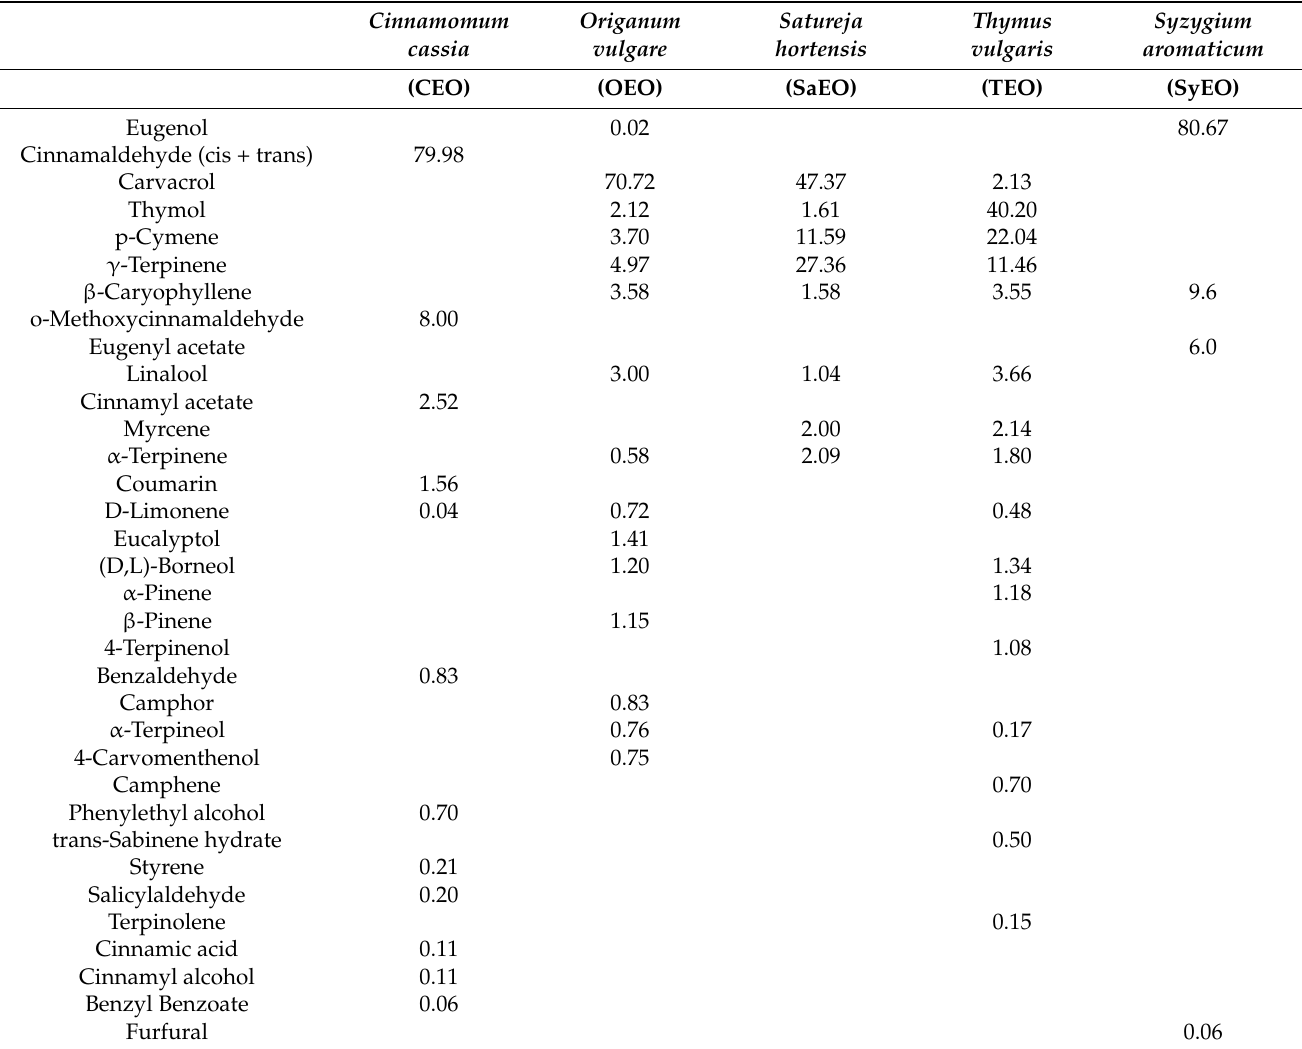
Table 1. Chemical compositions of commercial essential oils (%) determined by gas chromatography. The compounds are classified according to their concentration in all the tested EOs. These data are provided by the supplier. Cinnamomum Origanum Satureja Thymus cassia vulgare (CEO)